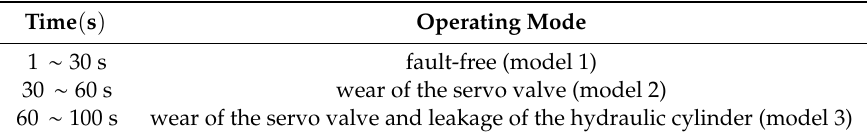
Table 2. The operating modes of HA in simulation 1.